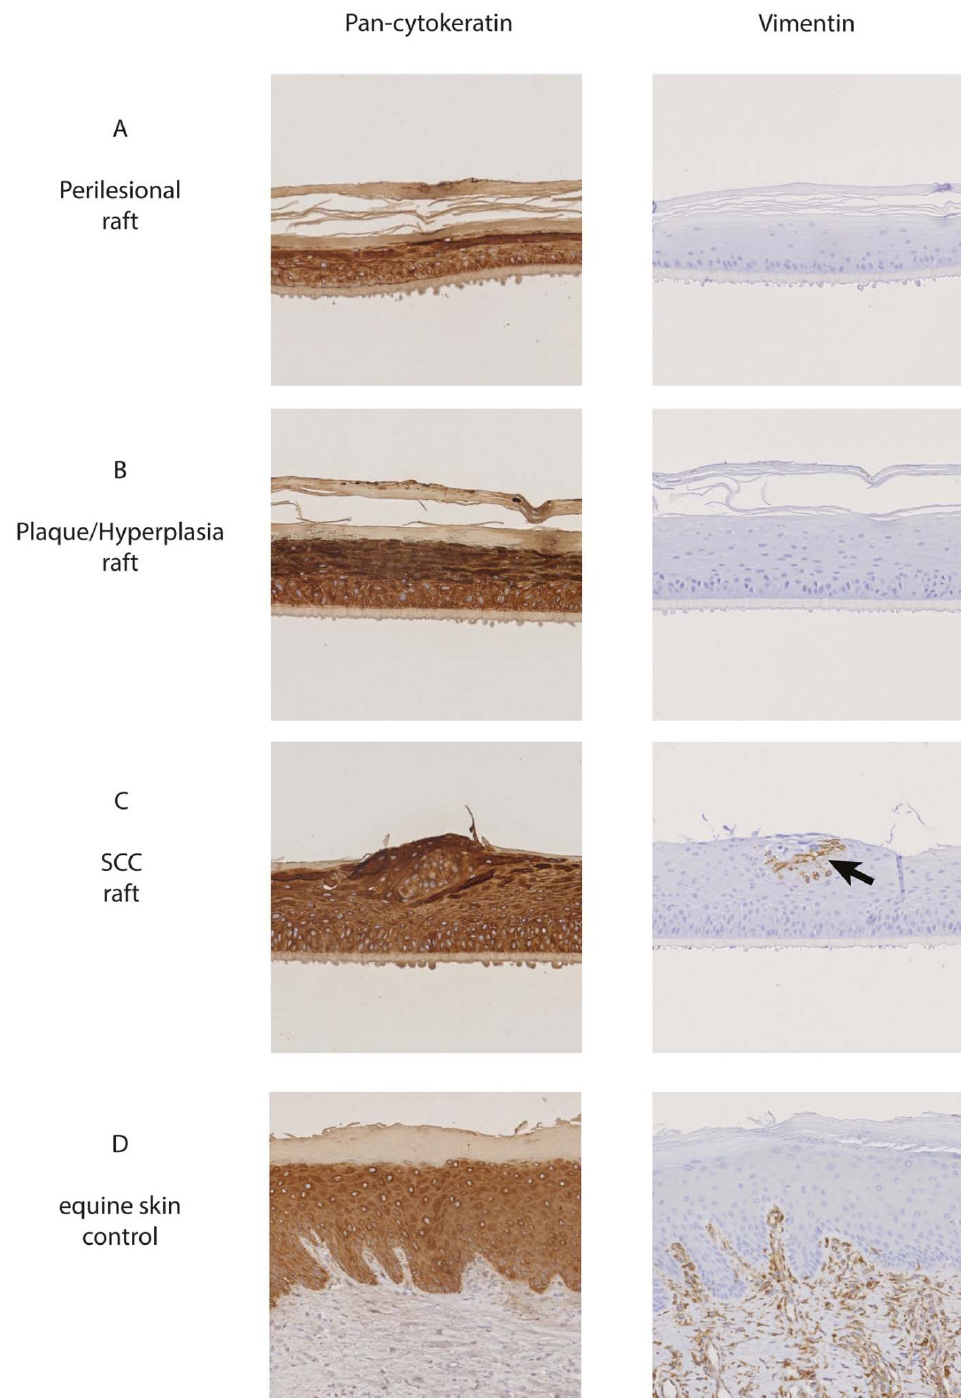
Figure A1. Pan-cytokeratin and vimentin immunostaining of raft cultures. Pan-cytokeratin and vimentin immunostaining of representative areas of perilesional skin-derived ( A ), plaque/hyperplasia-derived ( B ), squamous cell carcinoma (SCC)- derived ( C ), raft cultures and equine skin as control ( D ). All cells of the raft cultures are positive for the epithelial marker pan-cytokeratin, while the mesenchymal marker vimentin is not expressed within the raft cultures, except in a few cells within basaloid clusters in the upper layers of the SCC-derived raft (( C )—arrow). The equine skin control shows pan-cytokeratin positive epithelial cells in the epidermis and vimentin-positive mesenchymal cells in the dermis. No vimentin-positive cells are present in the epidermis. All photographs taken using 10 ×